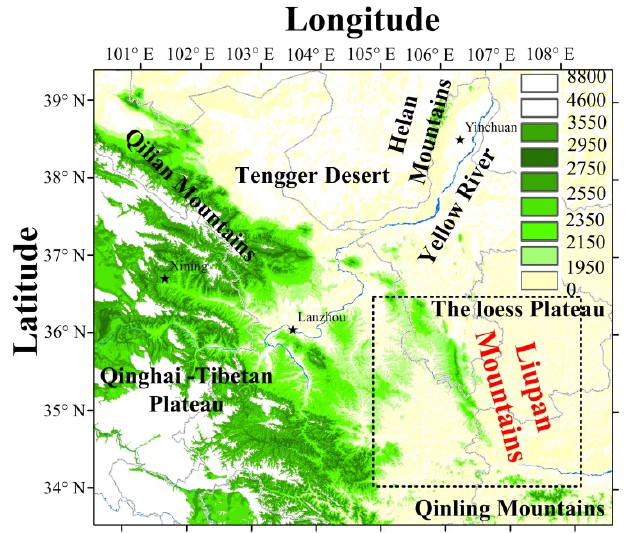
Figure 1. Topography of the Liupan Mountains and the study area (denoted by the black dashed frame).